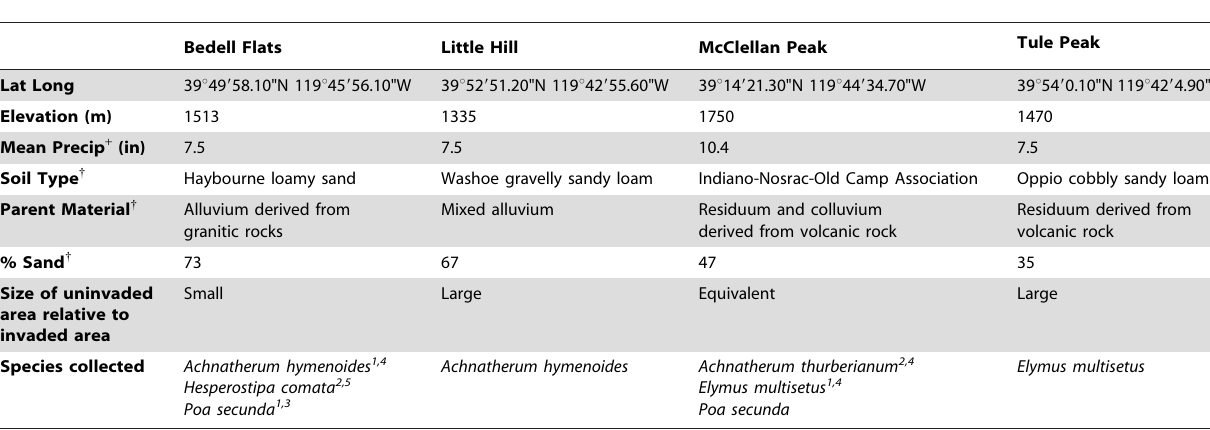
Table 1. Site and species characteristics of the four sampled